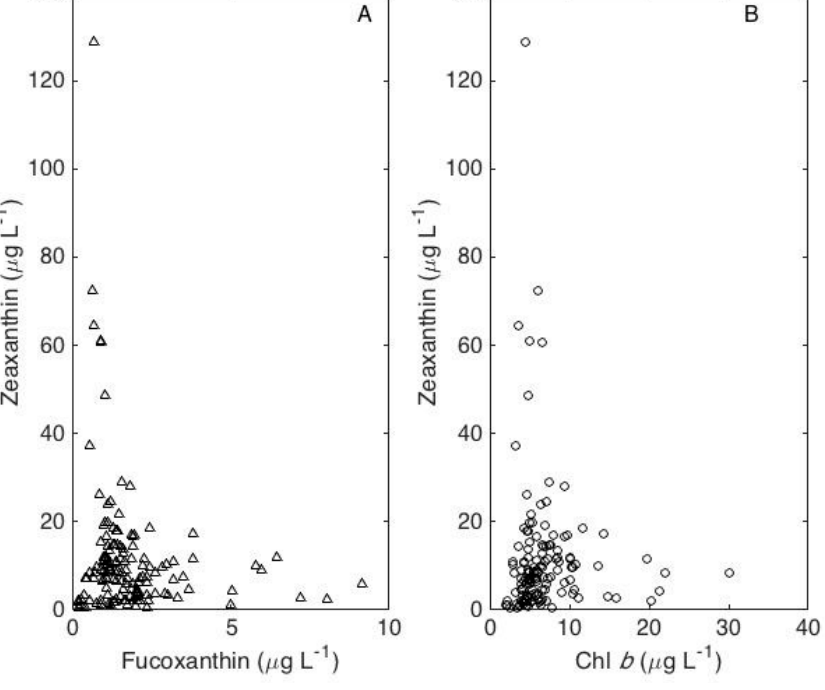
Figure 5. Relationships between zeaxanthin and fucoxanthin ( A ) and between zeaxanthin and chl b ( B